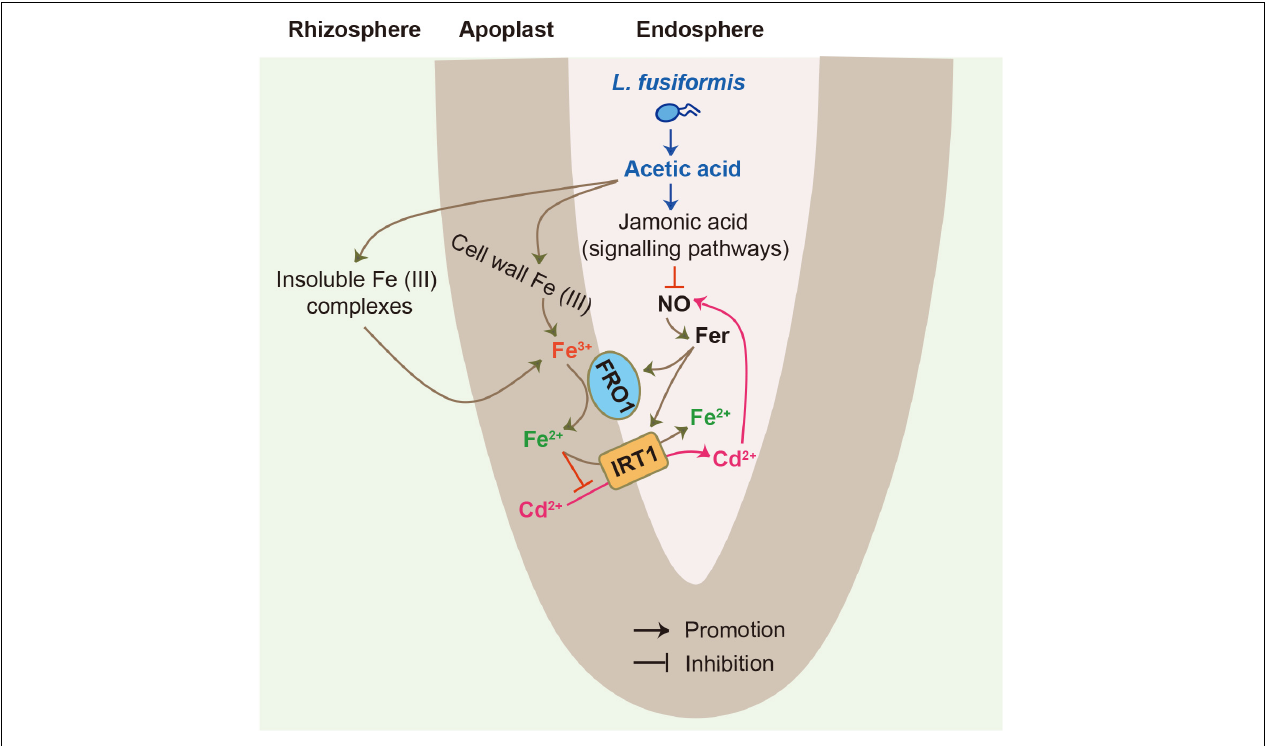
FIGURE 8 | A model for illustrating root endophytic bacteria L. fusiformis -mediated Cd detoxification in tomato plants. L. fusiformis -released acetic acid led to the increased bioavailability of rhizospheric and cell wall Fe. Moreover, high-level acetic acid also activated the JA signaling pathway to suppress root NO burst, thereby weakening Cd-induced Fe deficiency responses. These synergistic effects contributed to inhibit the IRT1-mediated Cd uptake in